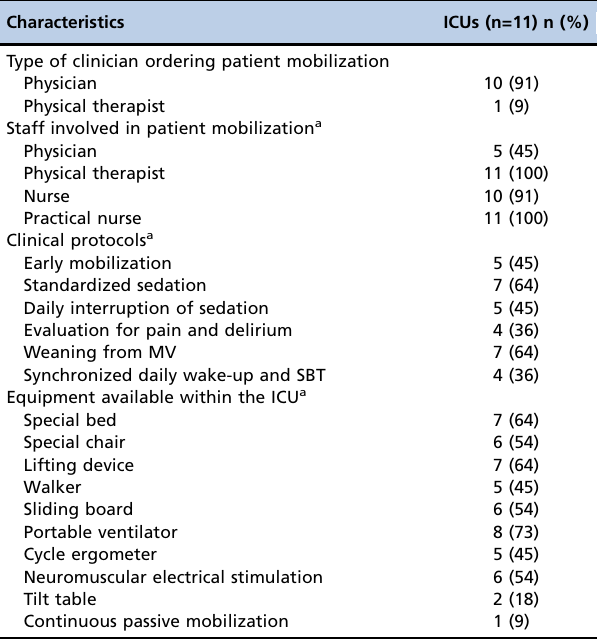
Table 2 - Mobilization practices, clinical protocols, and equipment available in the participating ICUs.